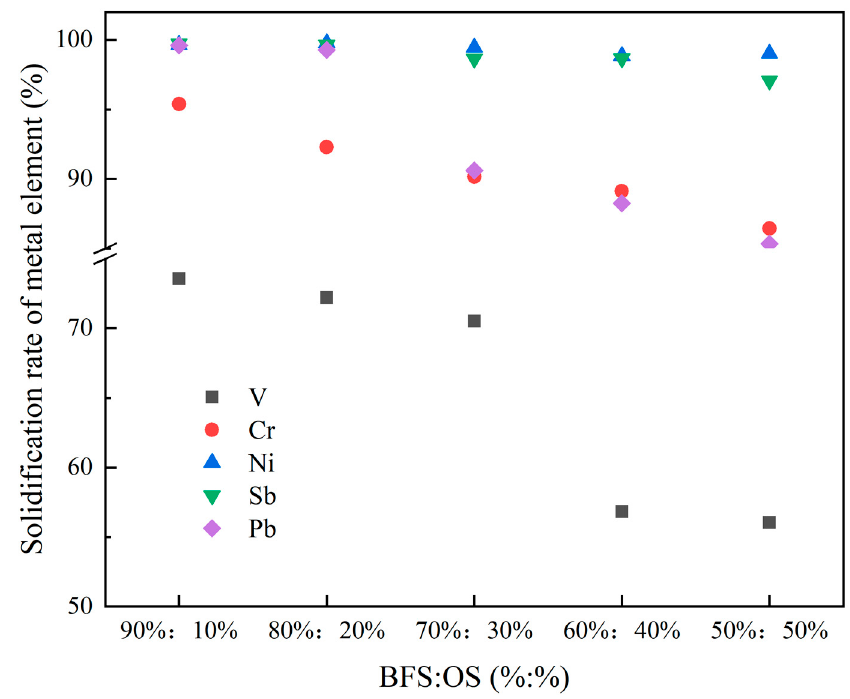
Figure 7. The solidification rate of heavy metal elements.